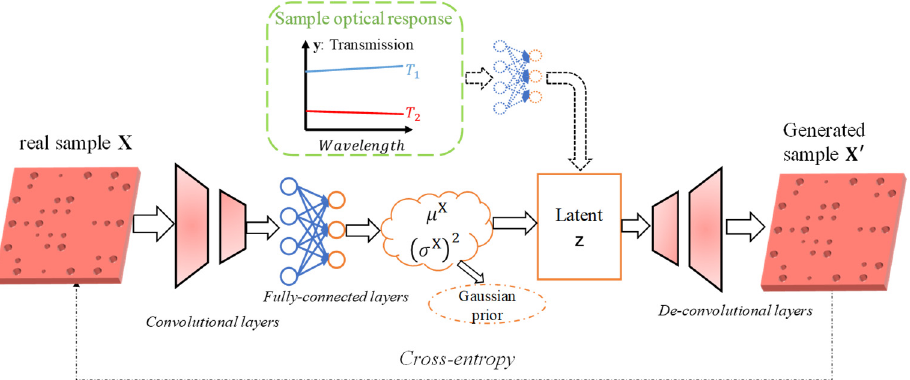
Figure 8. Training process of a CVAE to design a power splitter with QR-code like structure.